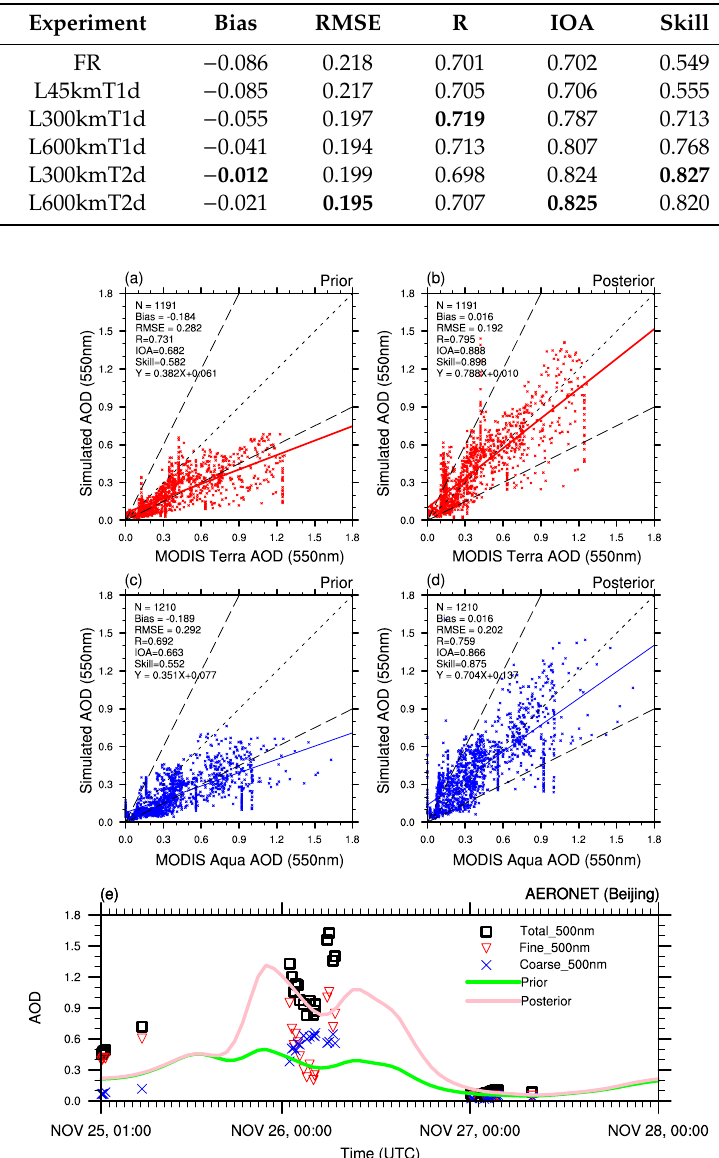
Figure 6. The scatter plots of the Moderate Resolution Imaging Spectroradiometer (MODIS) Terra-observed AODs and the simulated AODs with ( a ) priori dust emissions and ( b ) posterior dust emissions over the dust-dominated region for the period of 25–27 November 2018. The number of samples (N), statistical metrics (Bias, RMSE, R, IOA and Skill), and linear equations are also shown. The solid lines show the best linear fit between the variables in the x and y axes. The 1:1 ratio is represented by the dotted line, and the 2:1 ratio is represented by the dashed lines. ( c ) and ( d ) are similar to ( a ) and ( b ) except for the comparisons of MODIS Aqua. ( e ) The time series of the simulated AODs with priori and posterior emissions are compared with the Aerosol RObotic NETwork (AERONET)-observed AODs. The AERONET-retrieved fine and coarse mode AODs are also shown.